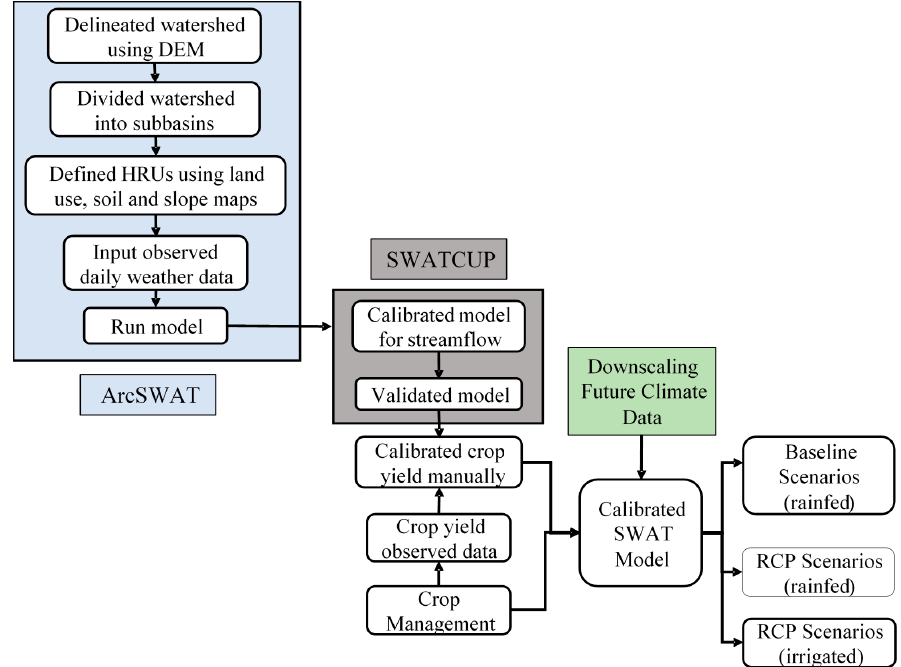
Figure 2. Comprehensive approach of future climate model application in the Soil and Water Assessment Tool (SWAT) model. ArcGIS-ArcView extension and interface for SWAT (ArcSWAT) and Calibration Uncertainty Program for SWAT (SWATCUP) were used for model setup and model calibration, respectively, showing the digital elevation model (DEM), the hydrologic response units (HRU), and the representative concentration pathway (RCP).